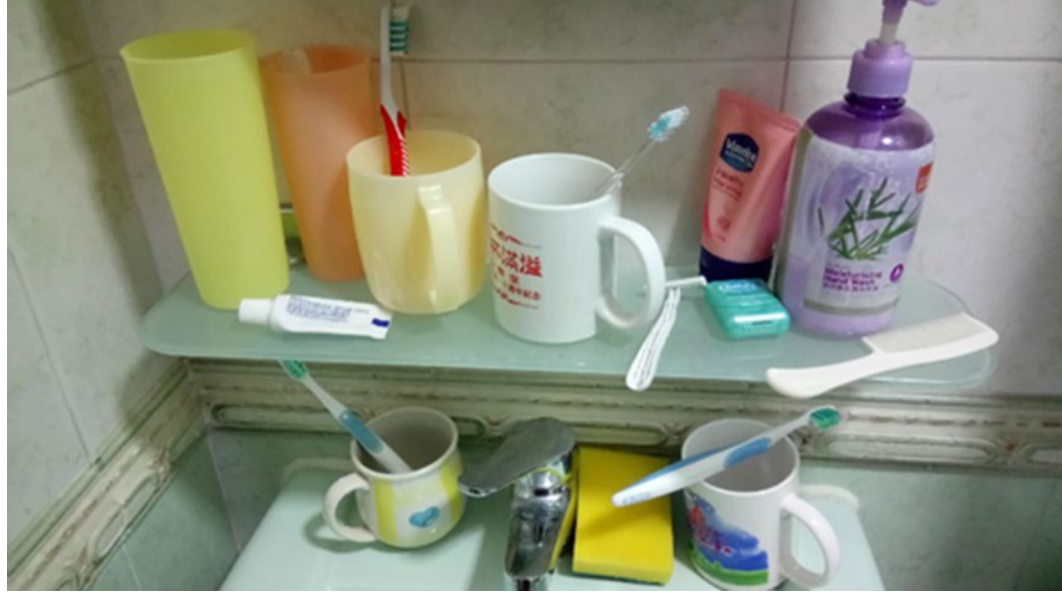
Figure 1. An untidy oral hygiene practice station in the bathroom.